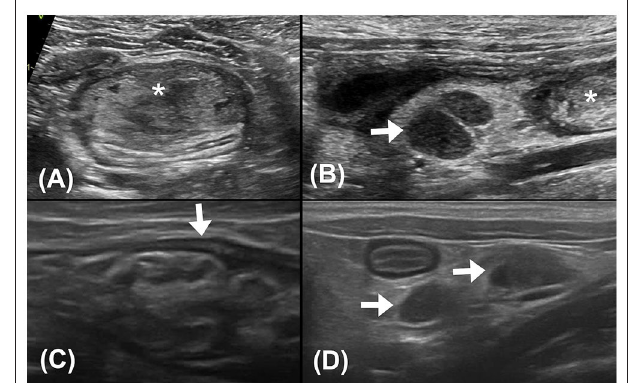
FIGURE 2 | (A) Transverse plane ultrasound image of the descending colon. A hyperechoic mass (asterisk) with heteroechogenicity between the submucosal and muscular layers of the descending colon was seen. (B) Sagittal plane ultrasound image of the colonic lymph nodes (0.6cm in thickness and 0.9cm in length). The colonic lymph nodes (arrow) adjacent to the mass (asterisk) appeared enlarged and hypoechogenic. (C) Follow-up sagittal plane ultrasound image of the descending colon 2 weeks after surgical evacuation. No mass effect was noted at the affected site. The intestinal layering (arrow) was relatively normal, with a thickened and corrugated mucosal layer. (D) Follow-up sagittal plane ultrasound image of colonic lymph nodes 2 weeks after surgical evacuation. The colonic lymph nodes (arrows) were smaller (0.4cm in thickness and 0.7cm in length) and with homogeneous echogenicity.